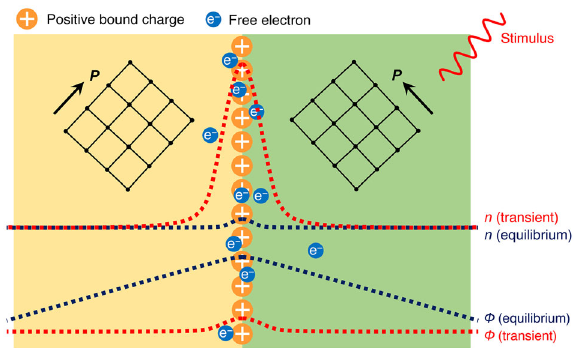
Fig. 1 Schematics of electronic and structural excitation around a charged ferroelectric domain wall. A positively charged ferro- electric domain wall shows a slighted raised electron concentration n and a locally maximized electric potential Φ at equilibrium. Upon excitation by an external stimulus, free electrons will migrate to the domain wall, resulting in an increased local concentration n which will partly compensate the polarization bound charge. This leads to a transient fl attening of the electric potential pro fi le Φ around these regions, which may further excite a transient response of the ferroelectric